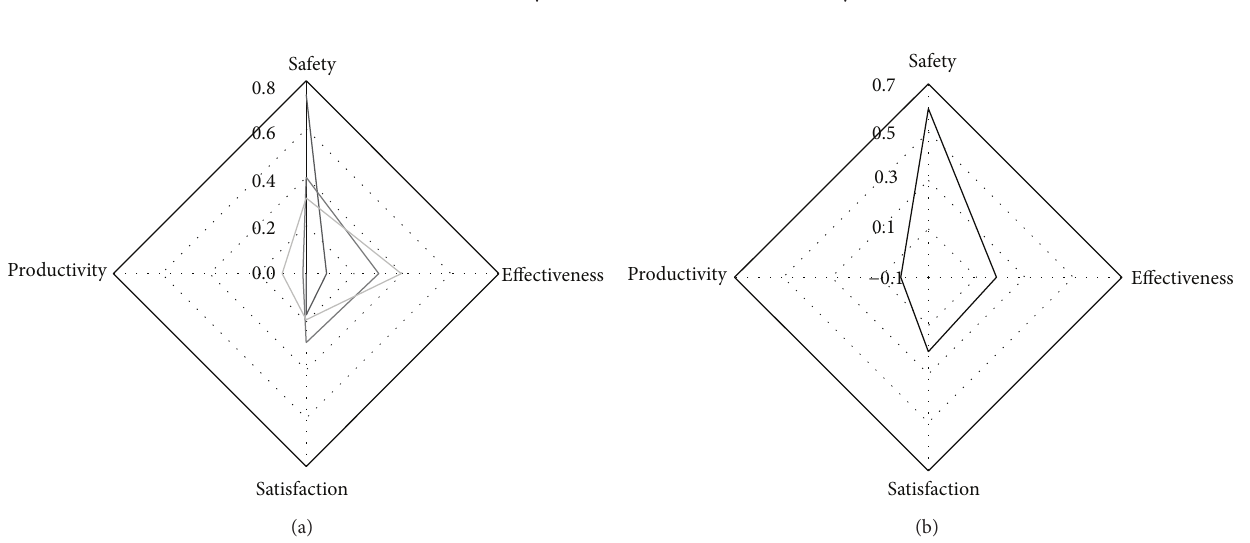
Figure 4: Quality in